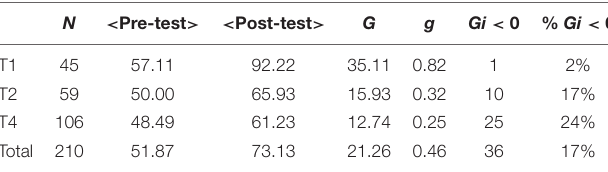
greater than 71 and 30% of the students had a relative learning gain less than